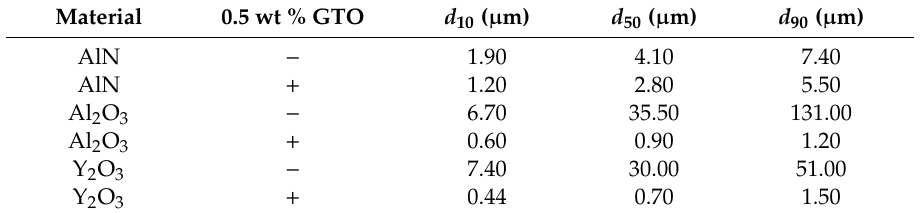
Figure 3. Viscosity comparison of 40 vol % dispersion with and without sintering additives.